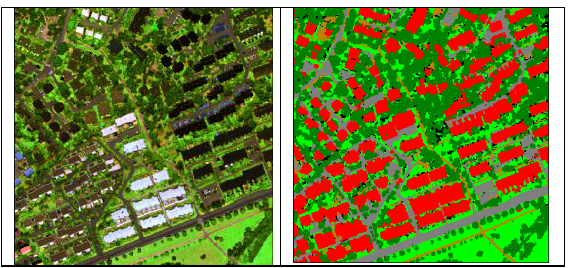
Figure 2. Optech Titan colour coded RGB image in which Red is Ch1, Green is Ch2, and Blue is Ch3 (left) and classified image (right).